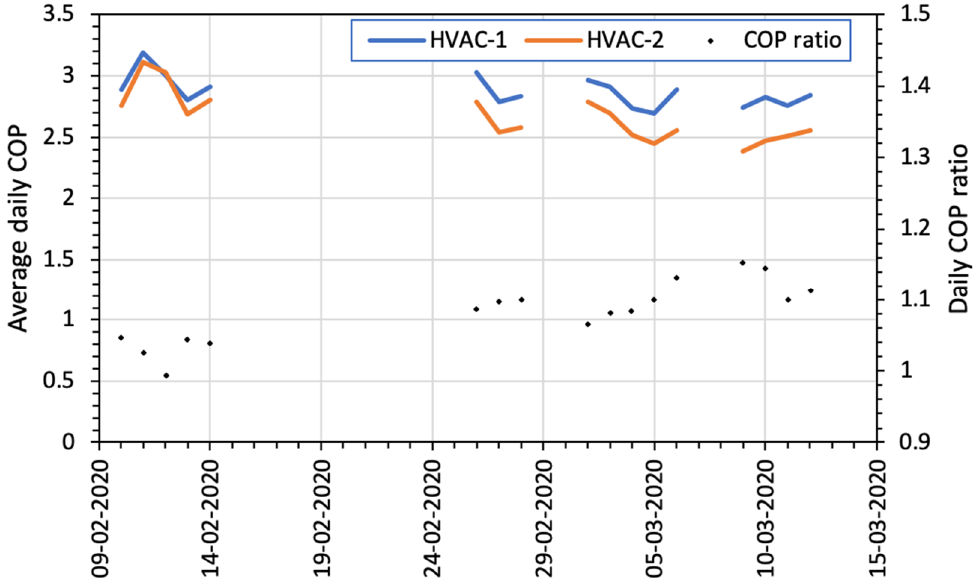
Figure 6. Average daily COP comparison and daily COP ratio between HVAC-1 and HVAC-2 (10